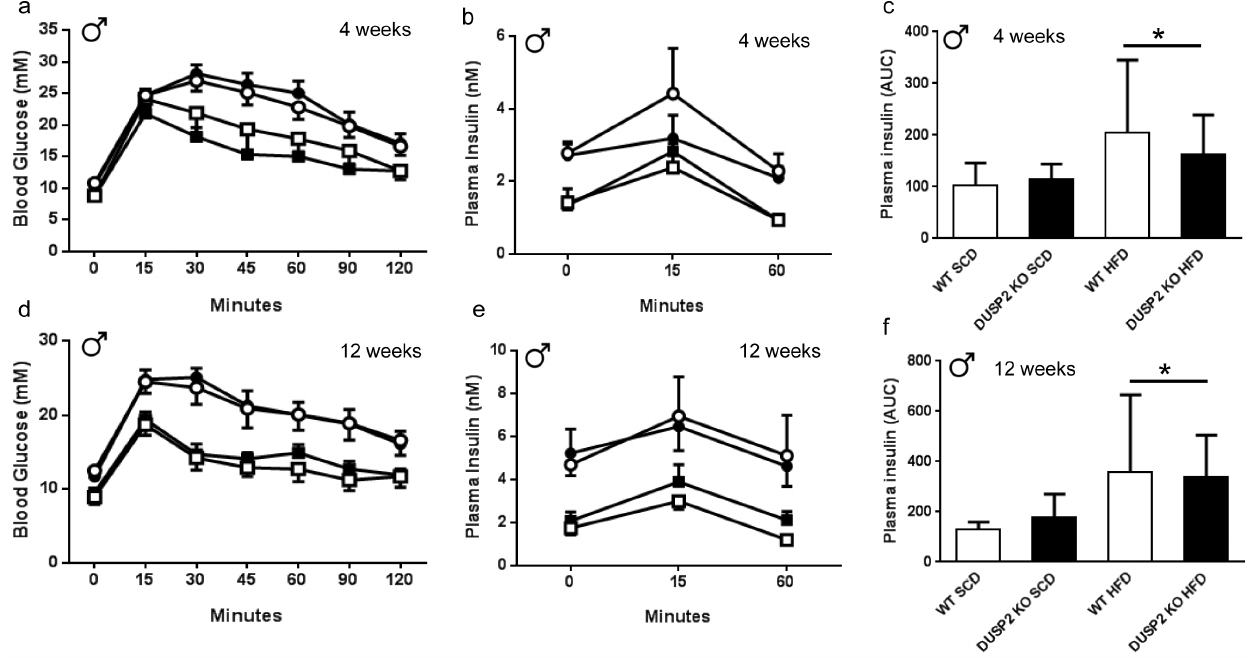
Figure 3. Glucose tolerance and insulin sensitivity in wt and dusp2 2 / 2 male mice after 4 and 12 weeks of diet. ( a and d ) oral glucose tolerance; ( b and e ) plasma insulin during the OGTT; and ( c and f ) plasma insulin area under the curve (AUC). * p , 0.05; Main Effect for HFD vs SCD. Data are mean 6 SD. White squares are wt mice fed SCD; Black squares are dusp2 2 / 2 mice fed SCD; White circles are wt mice fed HFD; Black circles are dusp2 2 / 2 mice fed HFD. Ns are 5, 8, 8 and 8, for wt SCD, dusp2 2 / 2 SCD, wt HFD and dusp2 2 / 2 HFD, respectively.